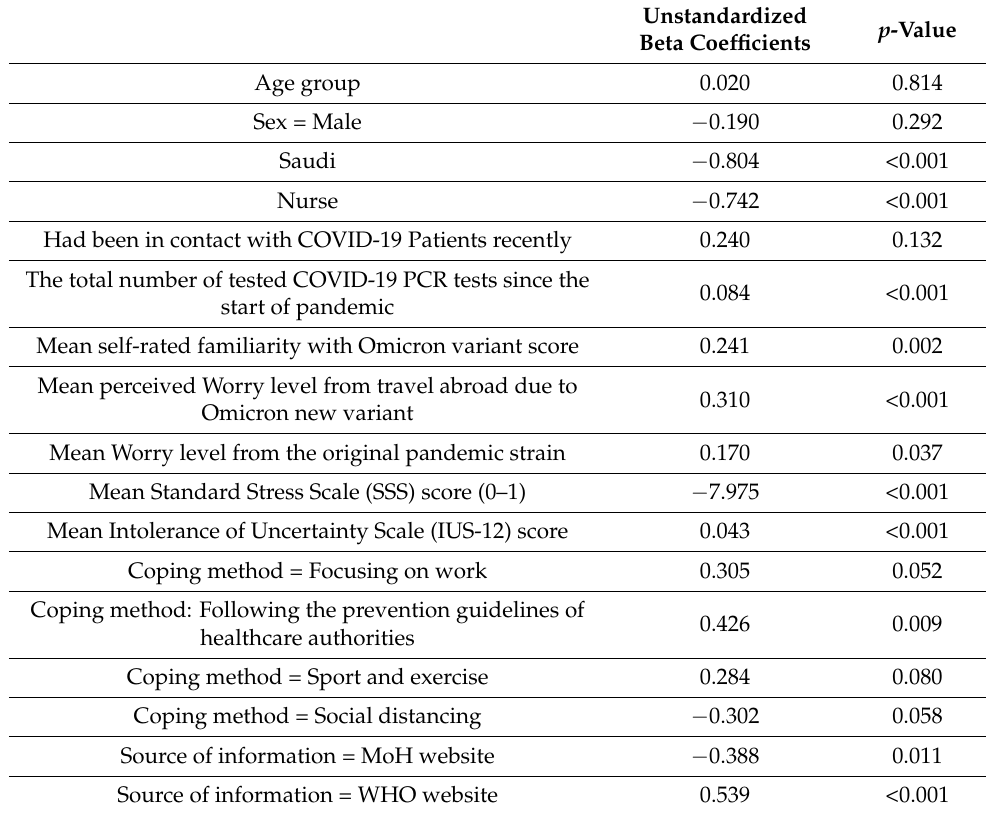
Unstandardized p -Value Beta Coefficients